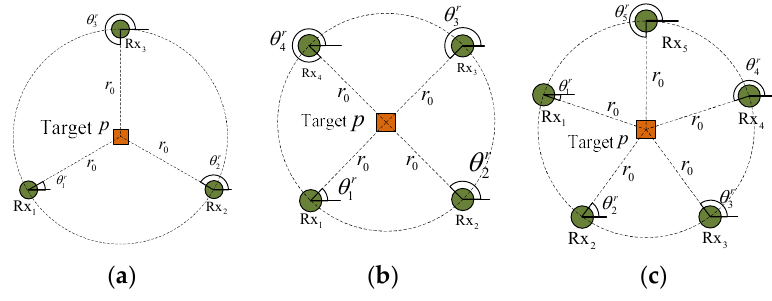
Figure 2 . Optimal receiver geometries for ( a ) Figure 2. Optimal receiver geometries for ( a ) M = 3 , ( b ) M = 3, ( c ) M =